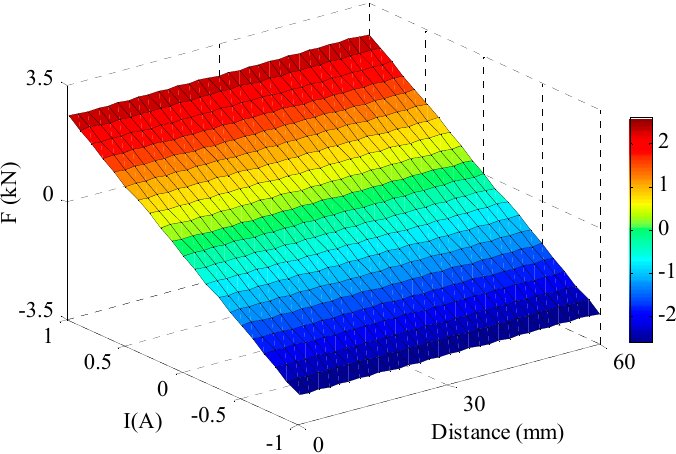
Figure 10. Experimental results of the magnetic flux density. Appl. Sci. 2020 , 10 , x FOR PEER REVIEW